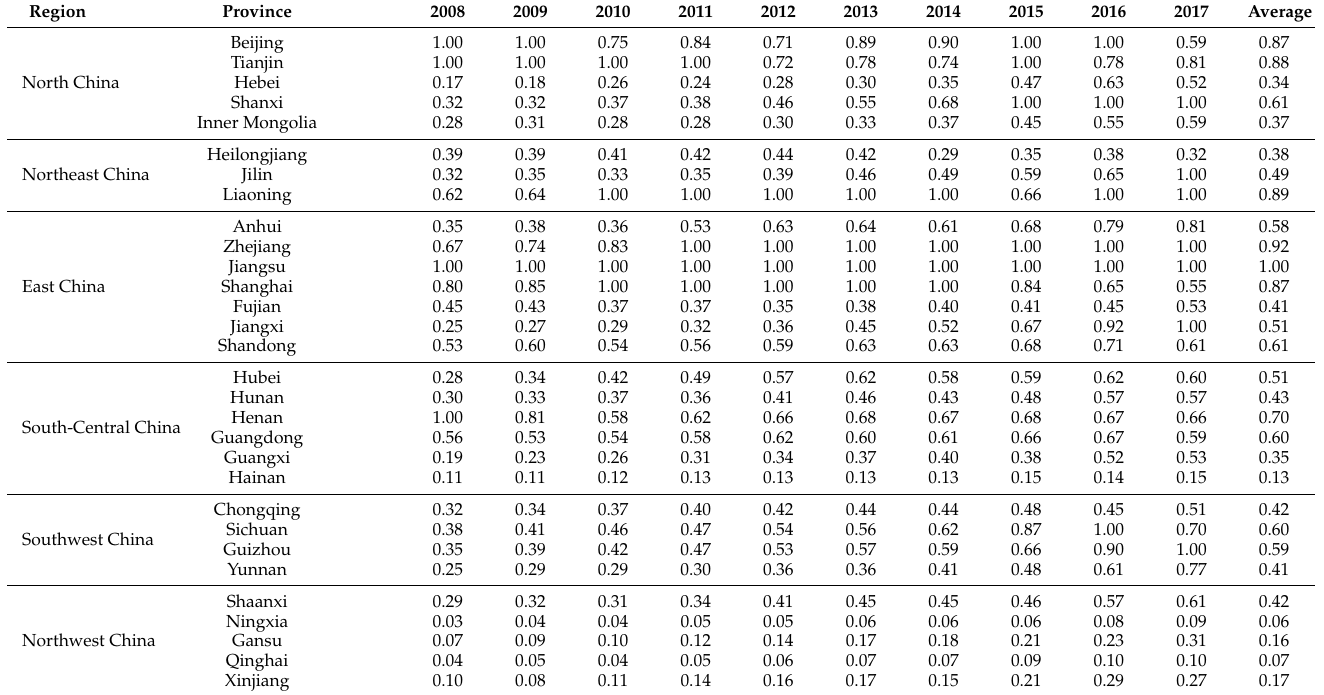
Table 6. Real eco-efficiency of China’s tourism industry (2008–2017). Region